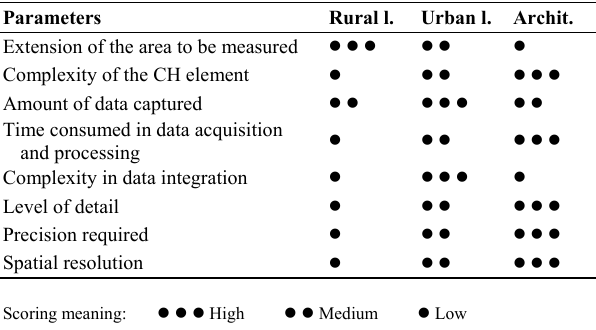
Table 4. Scoring of parameters that influence acquisition, processing and integration tasks depending on the CH scale of study.